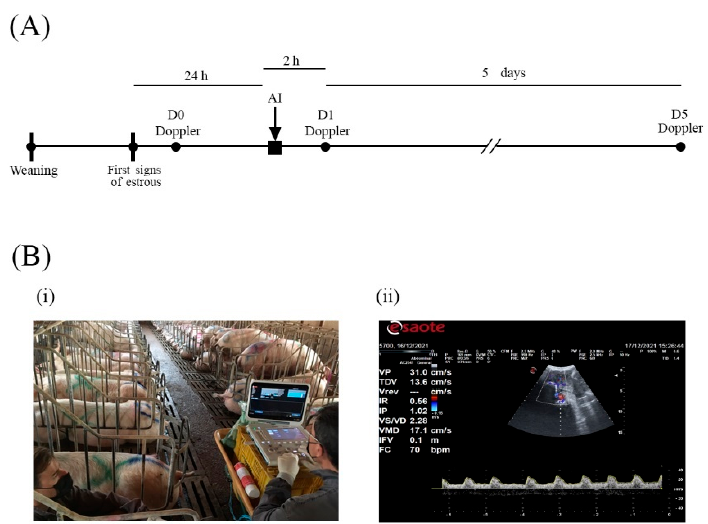
Figure 1. ( A ) Timeline of the procedures carried out during the study. Black dots (D0, D1, and D5) indicate the moment when Doppler ultrasound analysis was performed. The black square indicates the moment of artificial insemination (AI). ( B-i ) Detail of the procedure of transabdominal ultrasonography carried out during the analysis. The assay was performed by two researchers, one in charge of the ultrasound probe, while the other was analyzing the real-time images. ( B-ii ) A representative image was displayed by the ultrasound apparatus (MyLab TM alpha, Esaote España S.A., Barcelona, Spain) during the evaluation of the uterine arteries of a